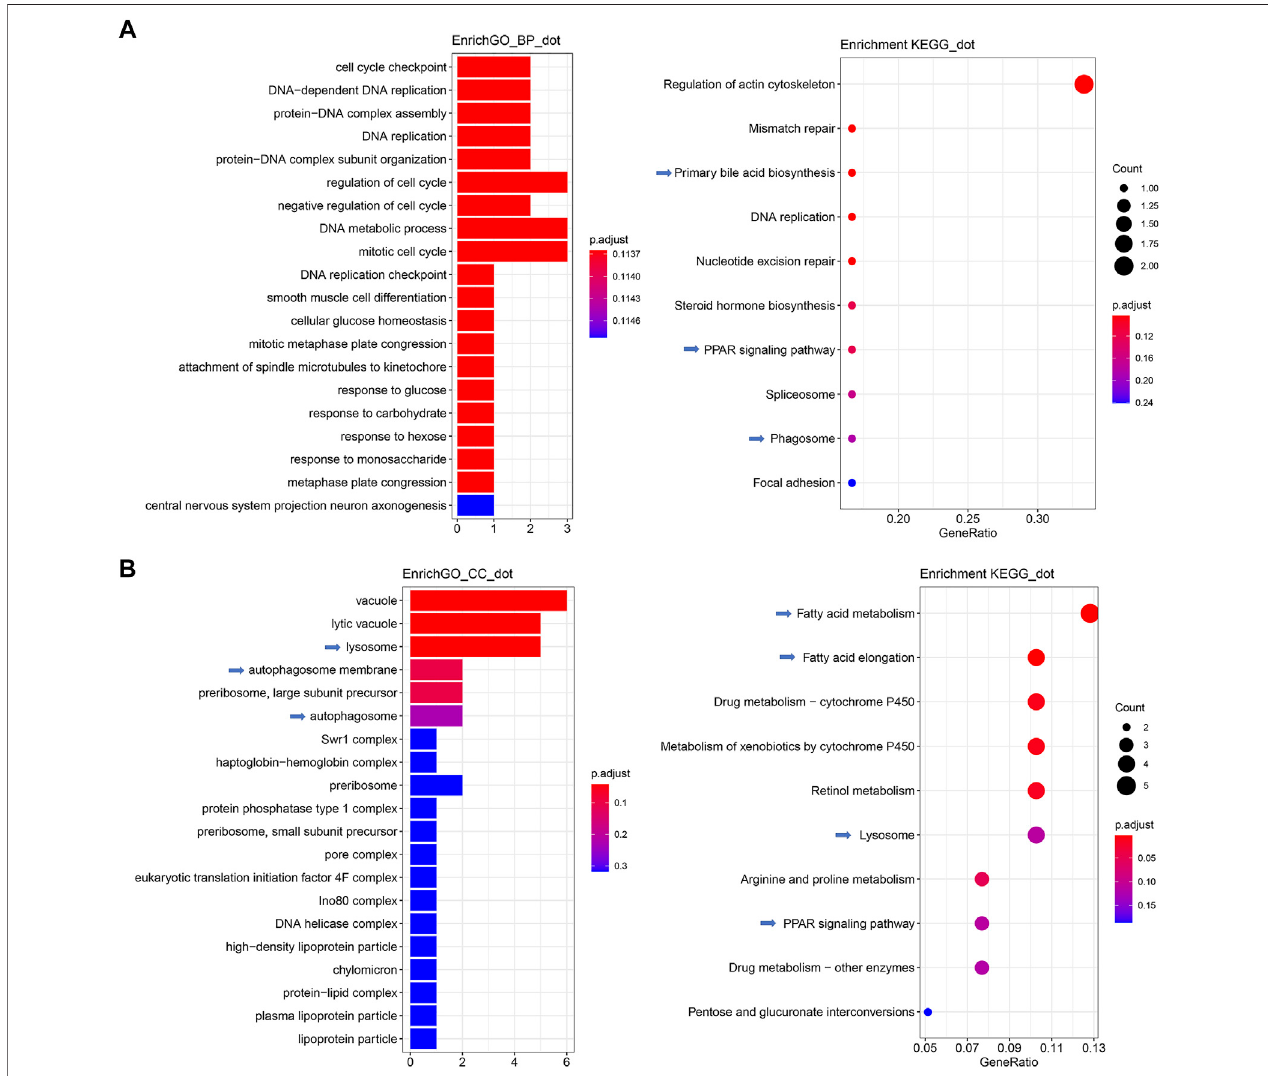
FIGURE 4 | GO terms and KEGG pathways enriched for both intestinal and hepatic DEGs in comparison between SB and SBM groups in zebra fi sh SBMIE adult model. (A) Keyintestinaltermsbiologicalprocesses(left)andKEGGpathways(right); (B) Keyhepatictermsforcellularcomponents(left)andKEGGpathways(right).The immune-related terms and pathways are labeled with